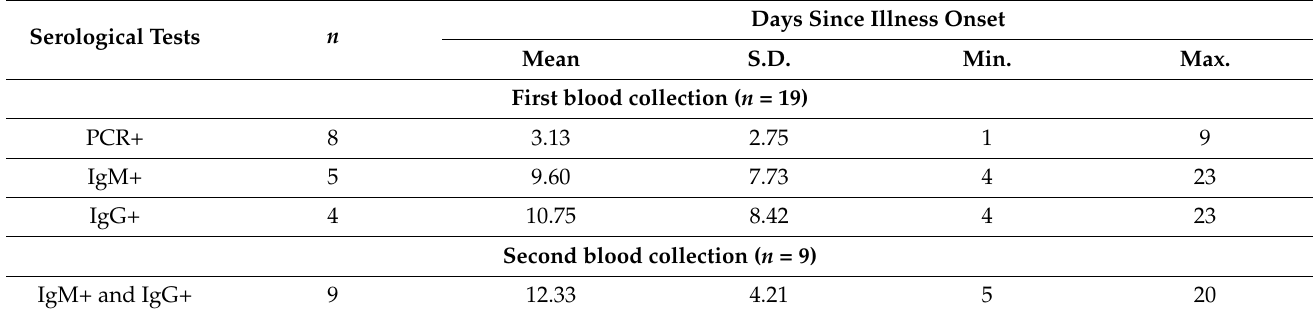
Table 2. Days from illness to serological